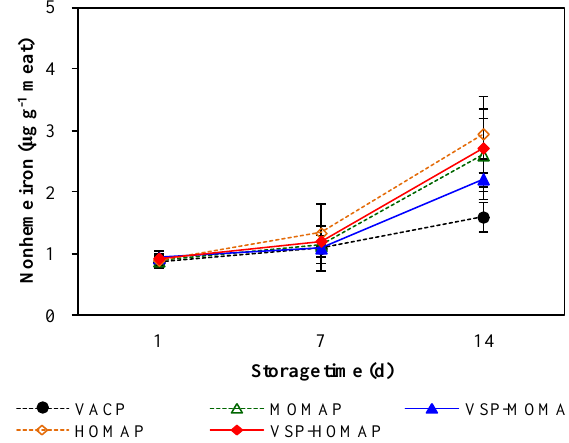
Figure 5. CIE a* value in sliced Hanwoo (Korean cattle) beef loin in packaging systems for 14 d at 4°C. Data are presented as means±SD. CIE, Commission Internationale de l’Eclairage; VACP, vacuum packaging; MOMAP, medium oxygen-modified atmosphere packaging (50% O 2 /20% CO 2 /30% N 2 ) alone; VSP- MOMAP, MOMAP combined with vacuum skin packaging; HOMAP, high oxygen-MAP (80% O 2 /20% CO 2 /0% N 2 ) alone; VSP-HOMAP, HOMAP combined with VSP; SD, standard deviation.